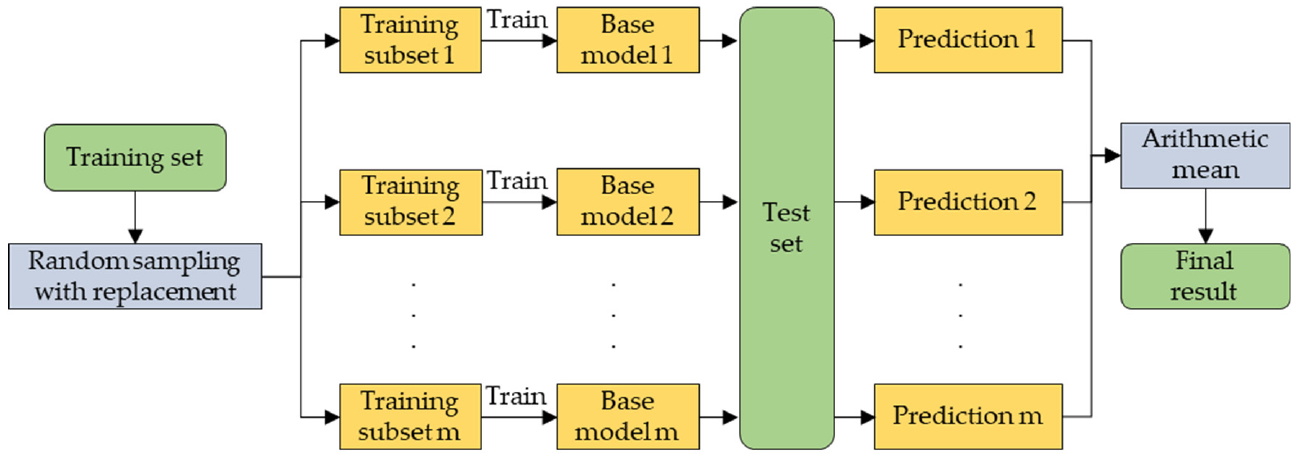
Figure 4. Bagging Algorithm Flowchart.